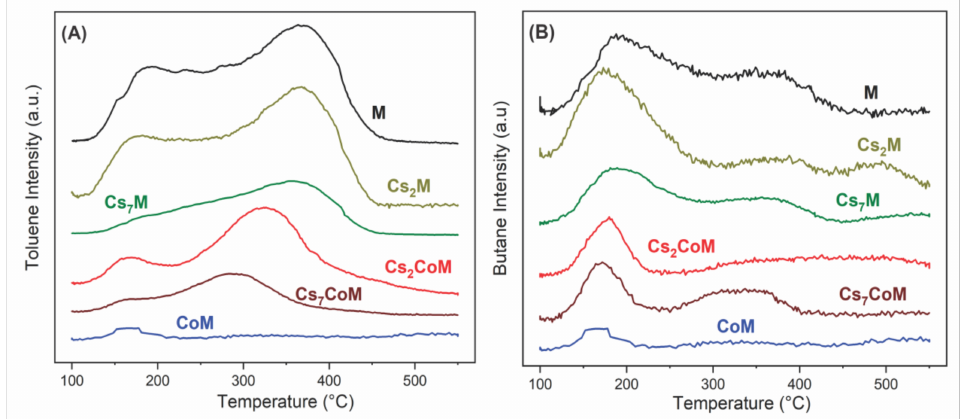
Figure 7. Profiles of temperature-programmed desorption (TPD) of ( A ) toluene or ( B ) butane after co-adsorption of butane and toluene mixture at 100 ◦ C. Conditions: 200 mg, desorption in He flow (40 mL/min); heating rate 10 ◦